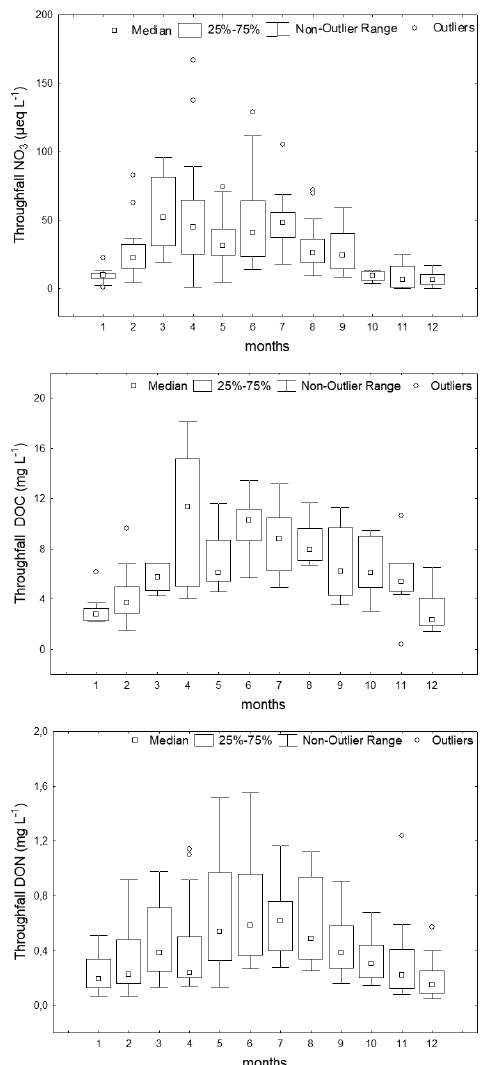
Figure 4. Box&Wisker showing the monthly variations of the NO the throughfall